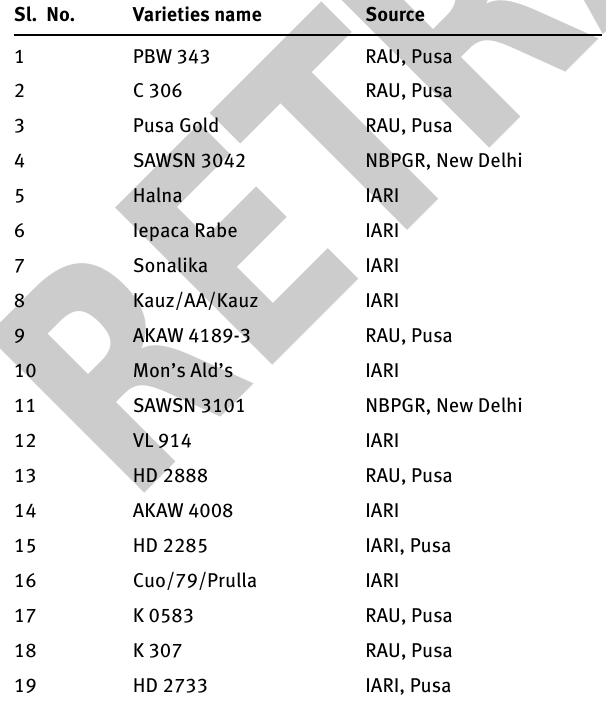
Table 1: List of genotypes and their sources Sl.